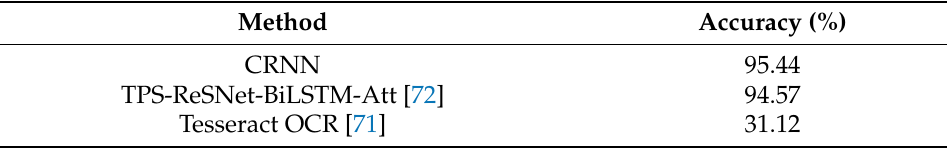
Figure 9. Architecture of the FCN-CRNN system. Table 3. Performance of the CRNN recognition